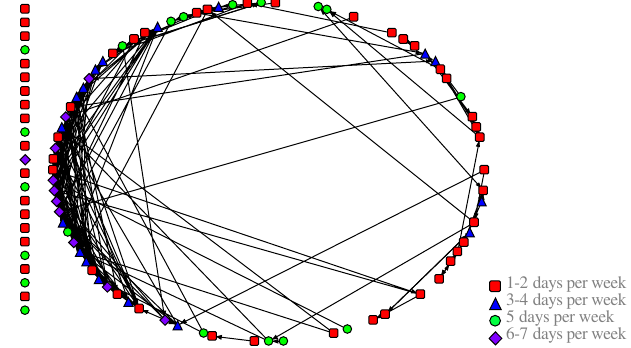
FIG. 3 (color online). Sociogram of Physics Learning Center participation. Nodes represent students, ties represent self- reported collaboration, red squares spent 1–2 days per week, blue triangles spent 3–4 days per week, green circles spent 5 days per week, and purple diamonds spent 6–7 days per week in the Physics Learning